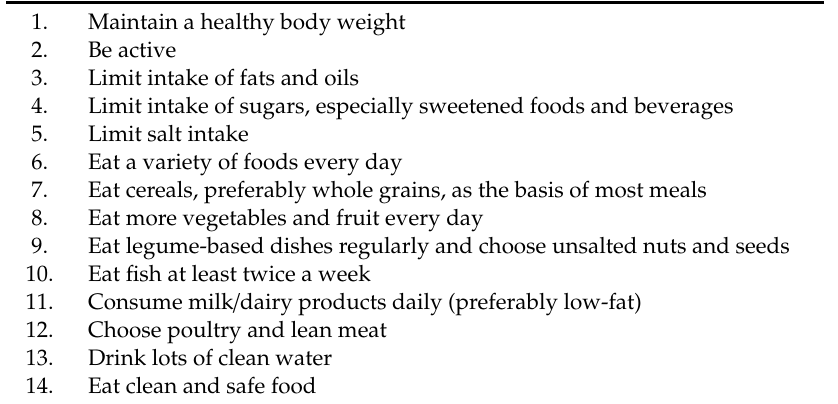
Table 4. Promoting a healthy diet for the WHO Eastern Mediterranean Region: user-friendly guide— key